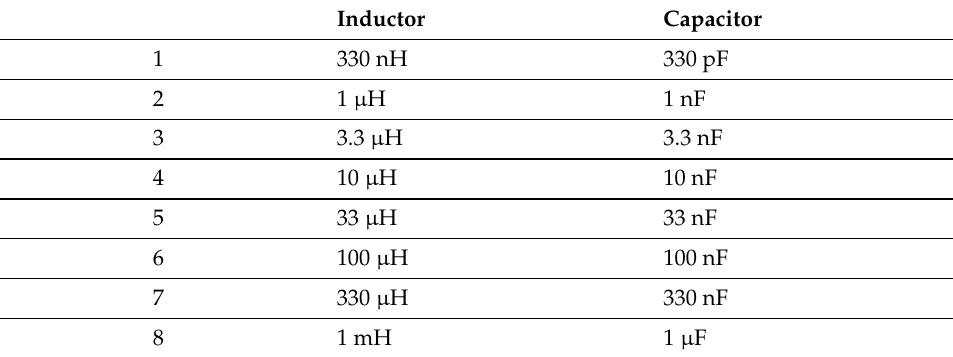
Table 1. The components of the LC terminator.